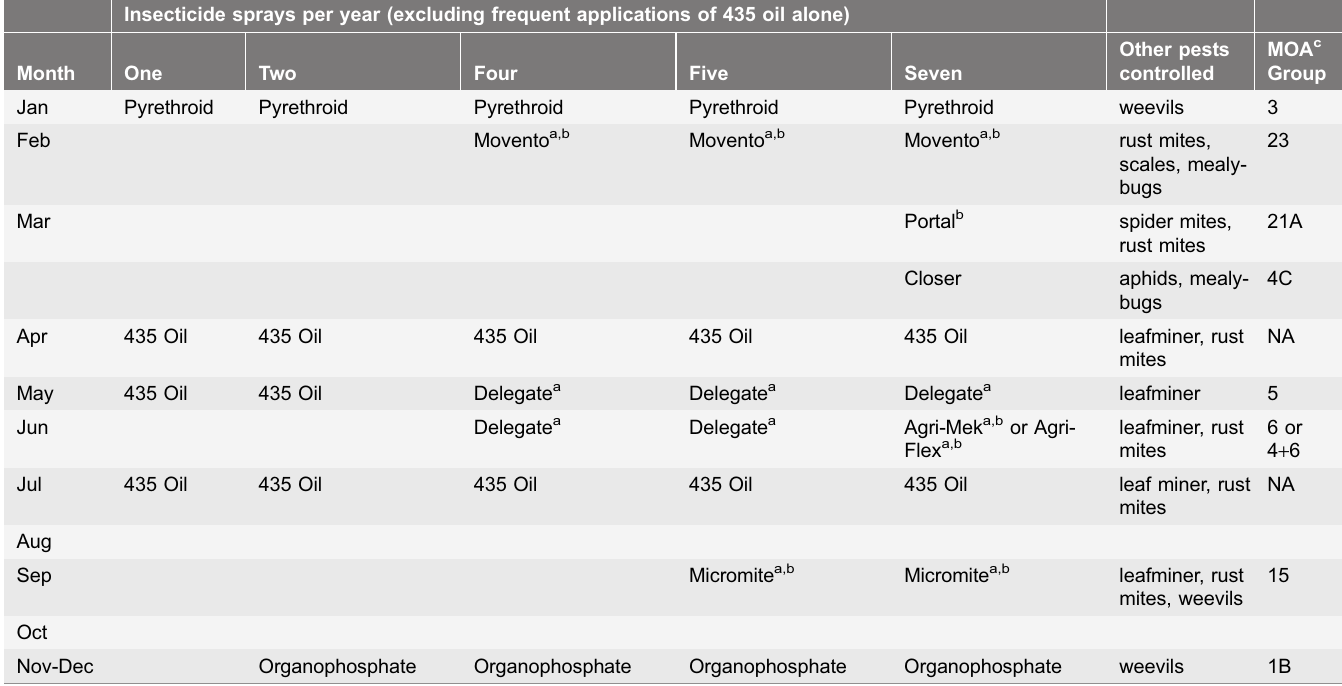
Table 6. Example insecticide spray programs for Diaphorina citri considering other pests in Florida citrus. Insecticide sprays per year (excluding frequent applications of 435 oil